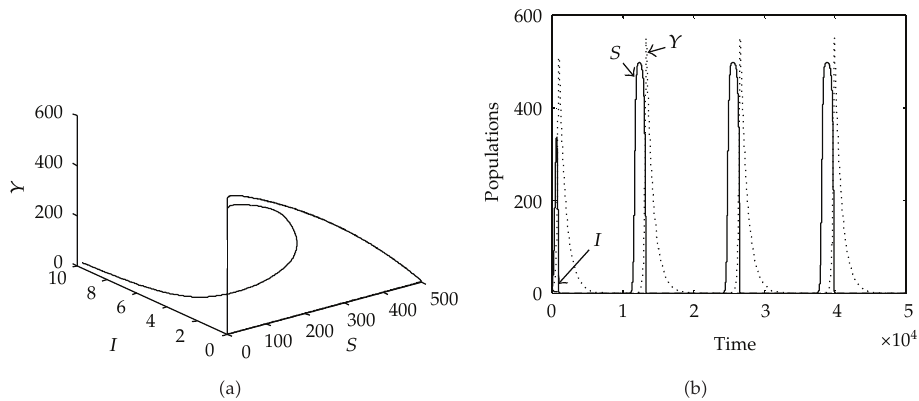
Figure 4: (cid:5) a (cid:6) System (cid:5) 2.1 (cid:6) approaches periodic attractor in Int. R 2 (cid:7) of the SY -plane for λ (cid:8) 0 . 01 with the rest of parameters are given by (cid:5) 6.1 (cid:6) . (cid:5) b (cid:6) Time series of the trajectory in (cid:5) a (cid:6)